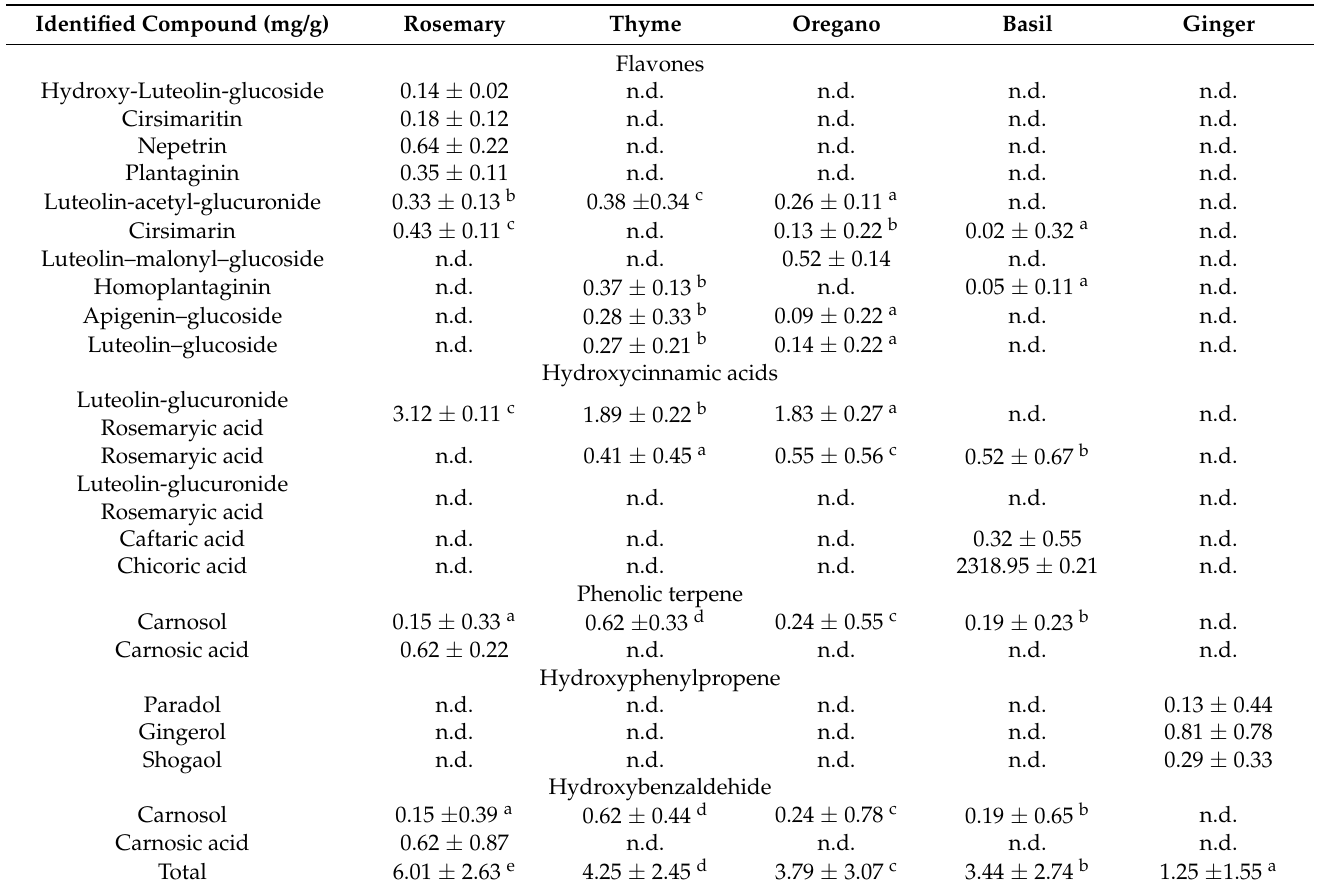
Table 4. Polyphenolic compounds identified in fresh